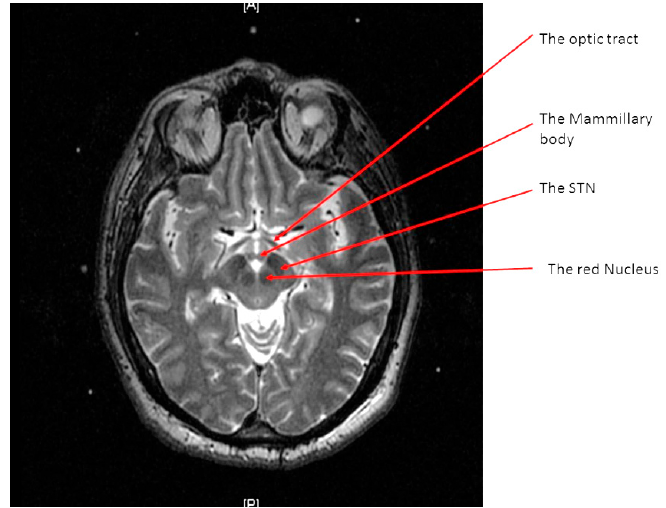
Figure 1. An axial T2 weighted magnetic resonance image (MRI) at the level of the midbrain showing the two subthalamic nuclei (STN).